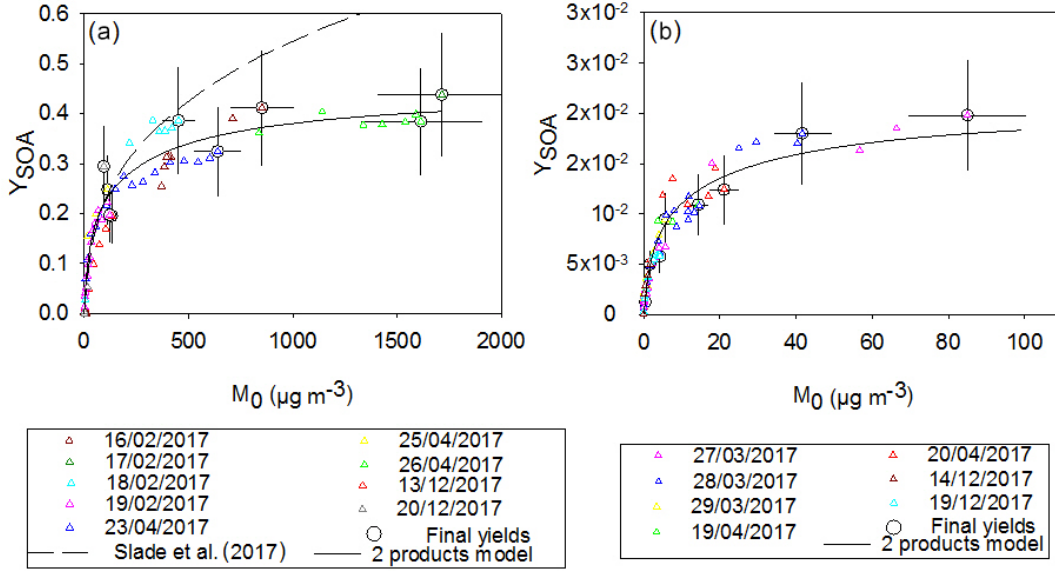
Figure 5. SOA yield as a function of the organic aerosol mass concentration measured for γ -terpinene (a) and for α -terpinene (b) . Final yields (circle marks) are shown with uncertainties. Data were fitted with a two-product model (solid black curve) and compared with the study of Slade et al. (2017; dashed